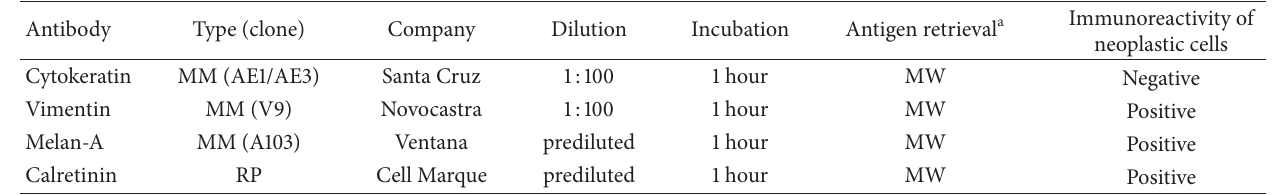
Antibody Type (clone) Company Dilution Incubation Antigen retrieval a